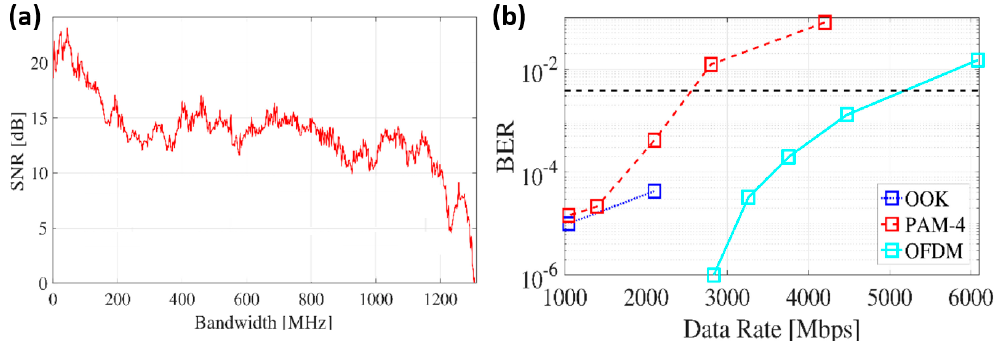
Figure 10. ( a ) Signal-to-noise (SNR) curve plotted against the bandwidth attained for Orthogonal Frequency-Division Multiplexing (OFDM) using the reported µ-LED array; ( b ) BER plotted against the data rate attained by adopting OOK, 4-PAM and OFDM modulation schemes. [79] Figures reproduced with permission from IEEE.